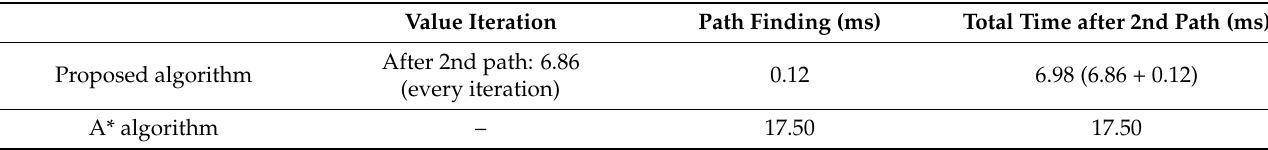
Figure 8. Comparison of MDP and A* path planning in the case of 50 obstacles. Table 2. No moving obstacles in the